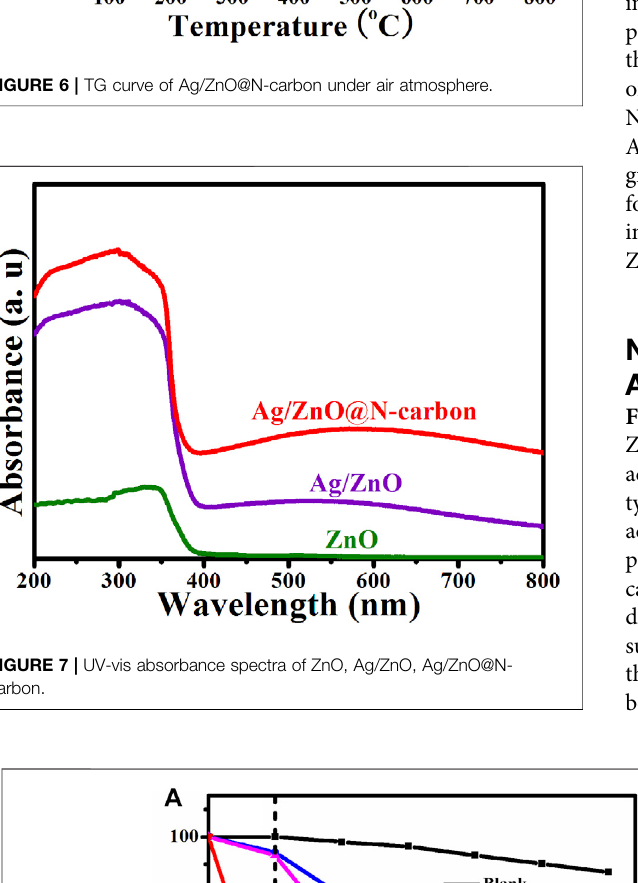
Frontiers in Chemistry |